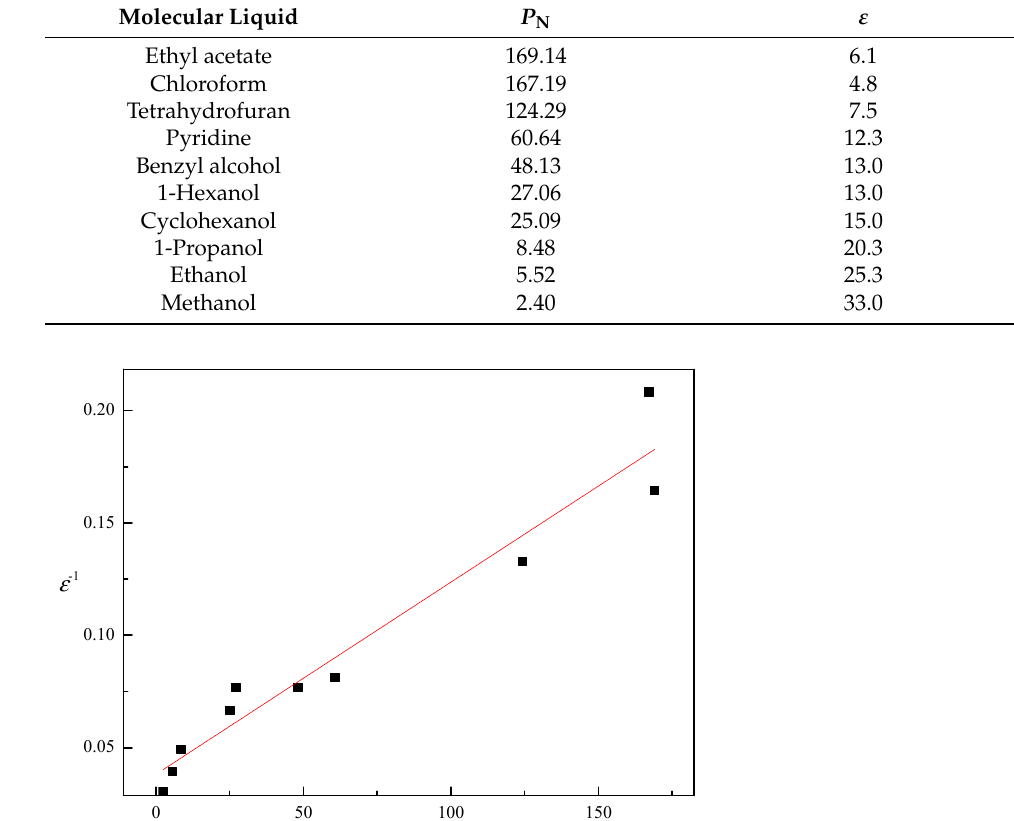
Table 7. P N and dielectric constant ( ε ) of various molecular liquids.